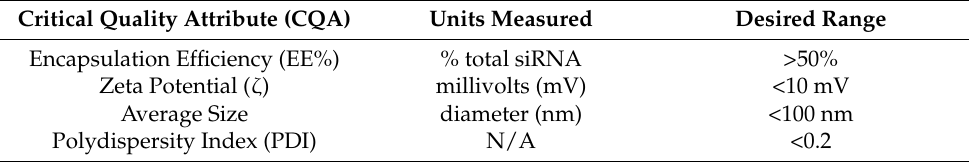
Table 1. Quality by design